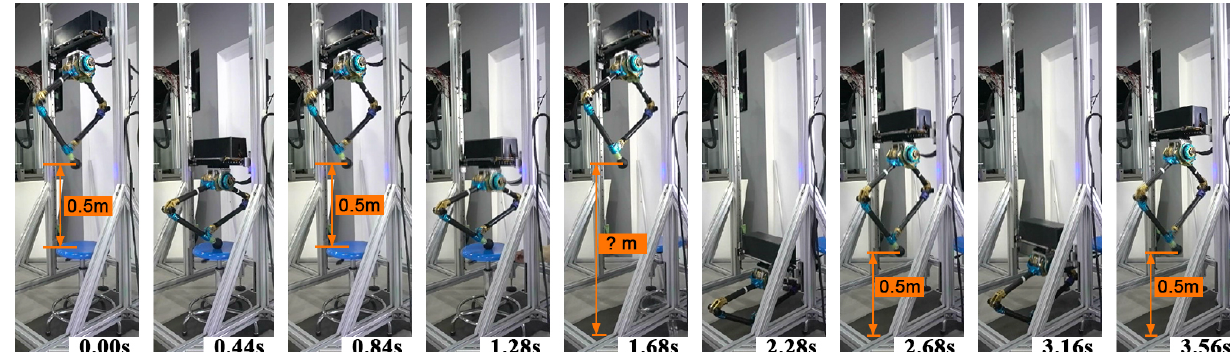
Figure 9. Photographs of robot leg during continuous constant height hopping. Initially, the leg is hopping on a stool; at 1.68 s, the stool was removed and the leg then fell to the